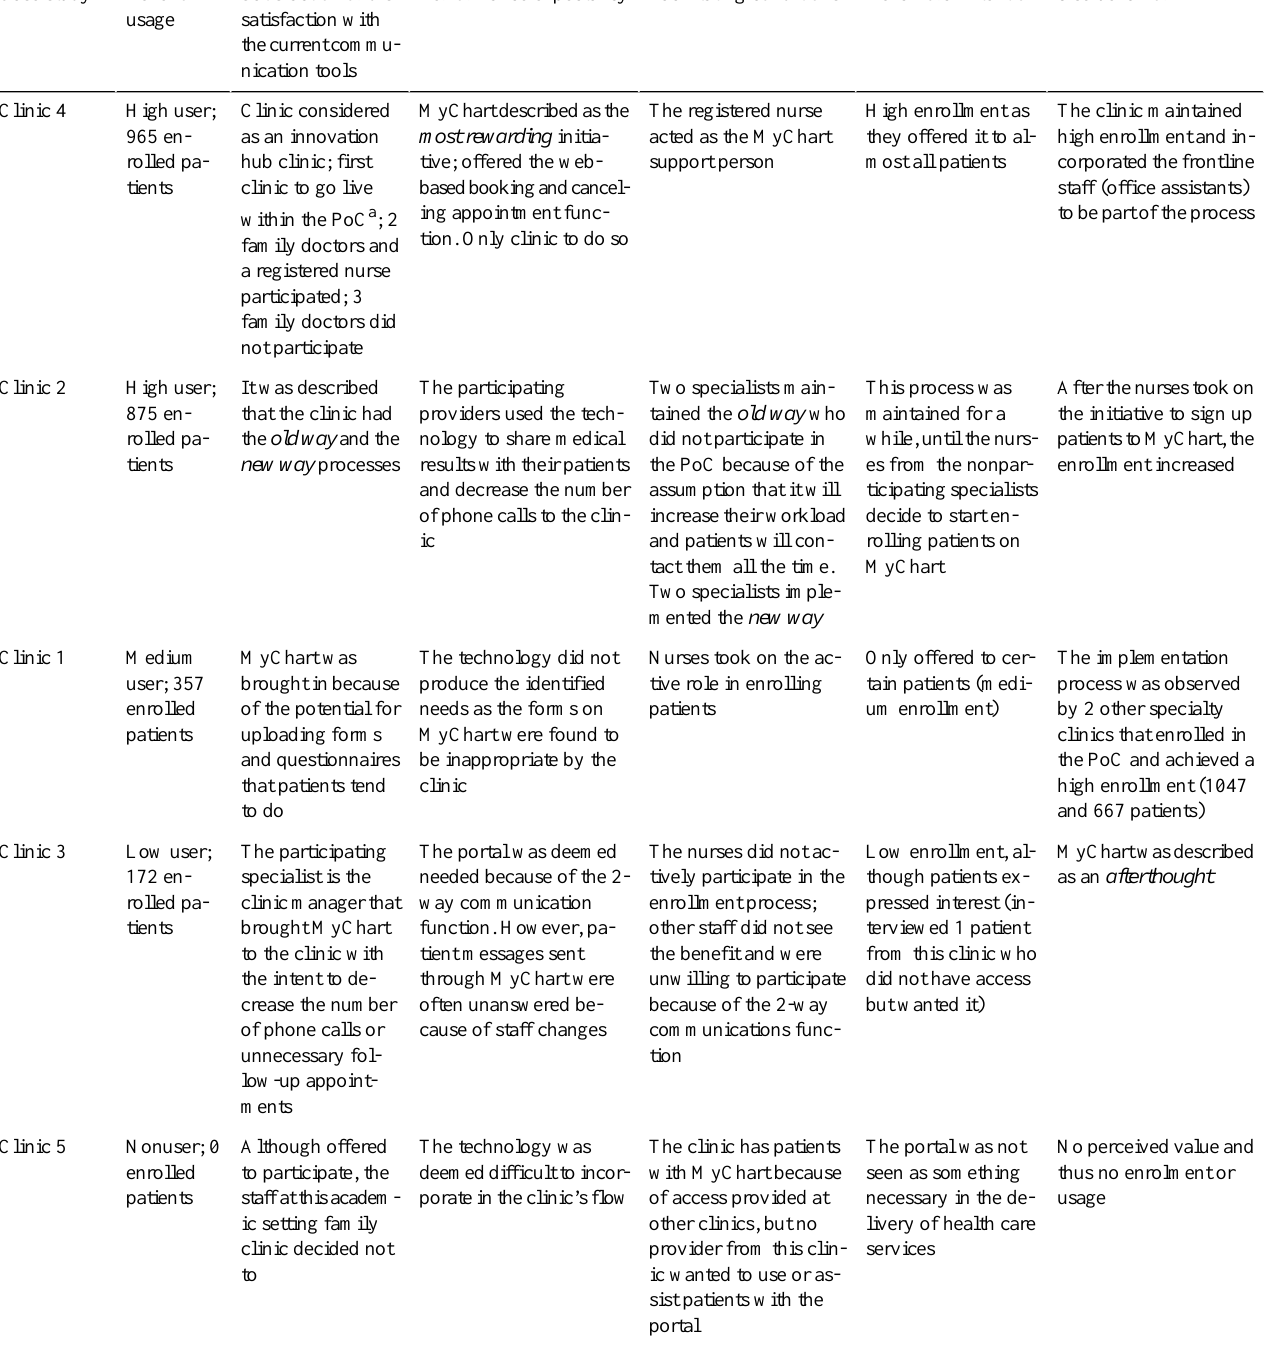
Table 5. Impact of the MyChart pilot on each case